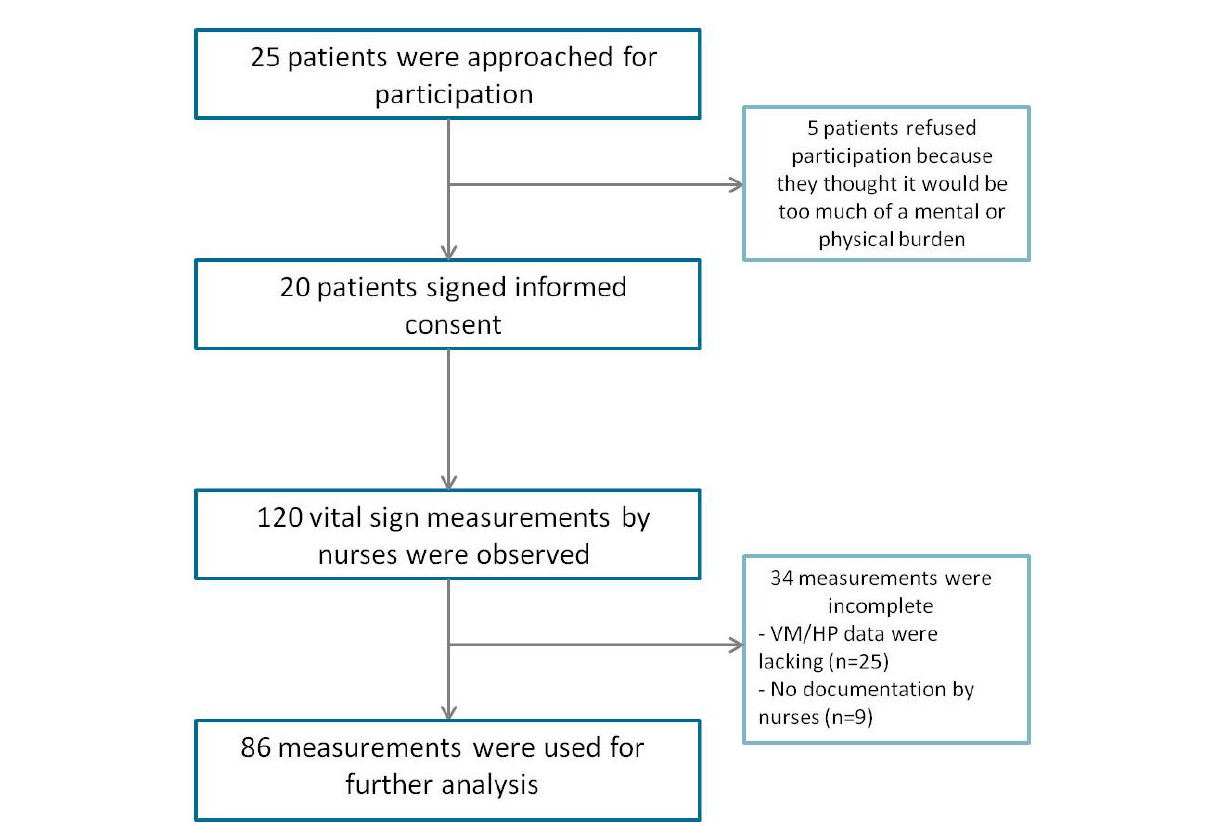
Figure 2. Included patients and vital sign